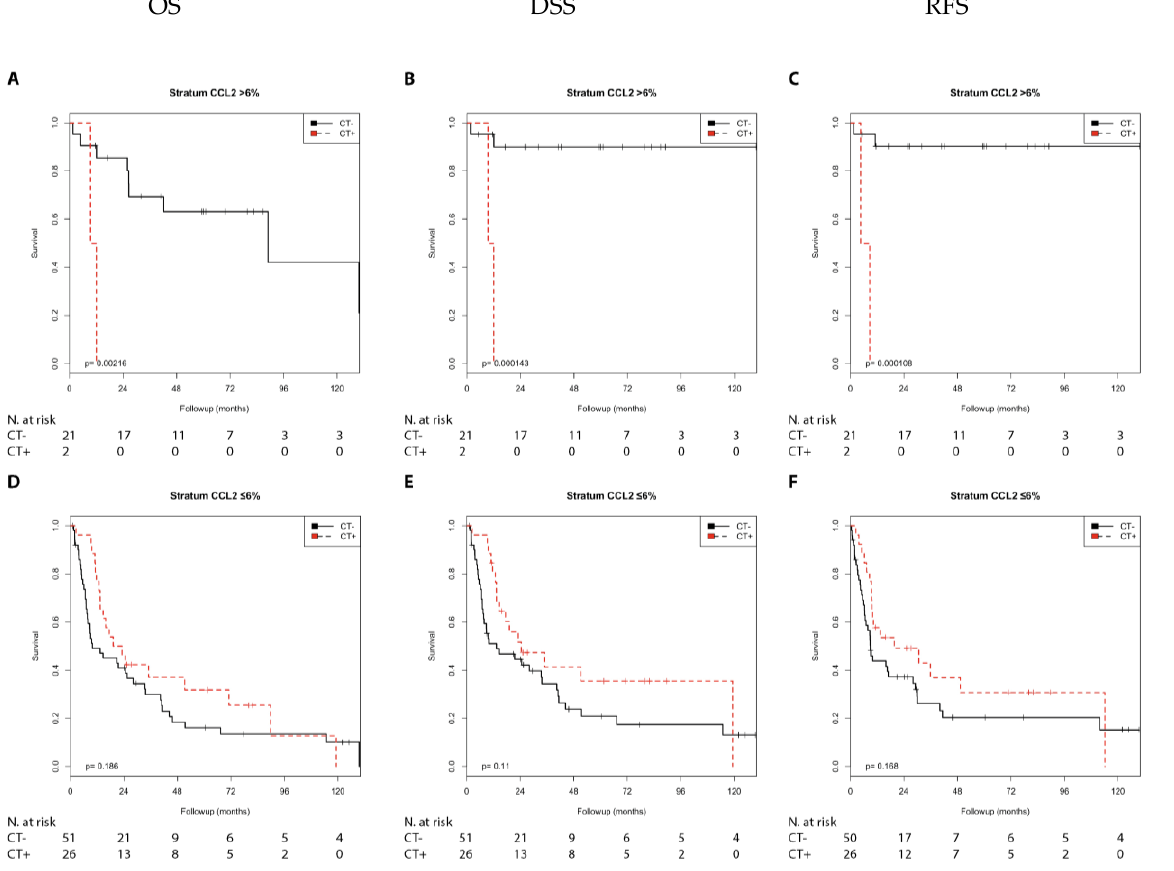
Figure 4. Kaplan–Meier analysis: Association of chemotherapy with prognosis (OS, DSS, and RFS) in the pT2/pT3 + 4 groups stratified by CCL2 expression (>6% or ≤ 6%). In the pT2 group ( A – C ) with CCL2 (>6%), chemotherapy was associated with shorter OS ( A ; p = 0.002), shorter DSS ( B ; p < 0.001), and shorter RFS ( C ; p < 0.001). In the pT3 + 4 group ( D – F ) with CCL2 ( ≤ 6%), chemotherapy was not associated with OS ( D ), DSS ( E ), or RFS ( F ).